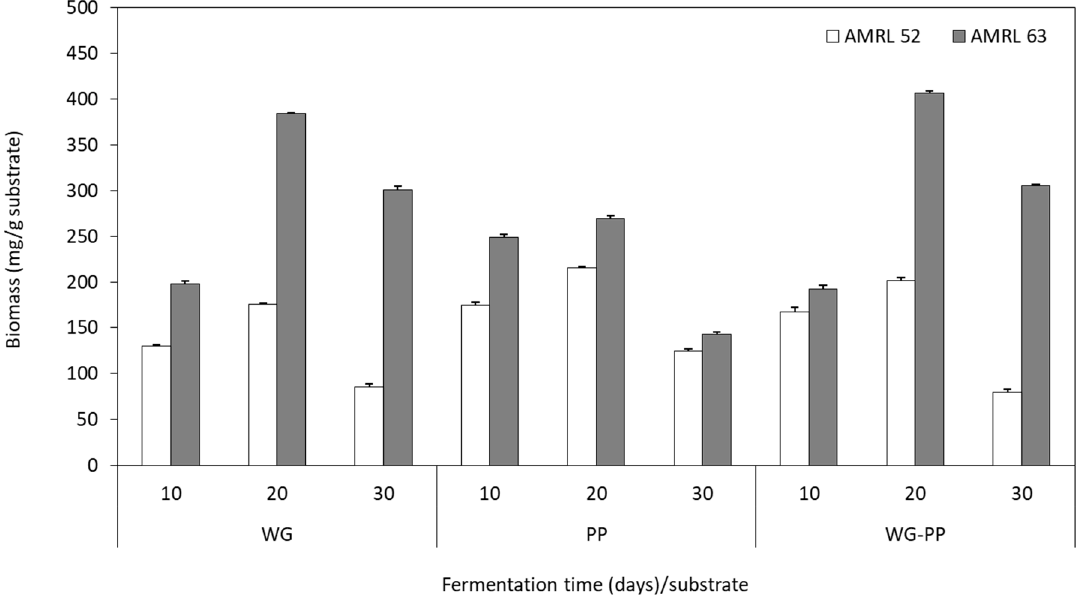
Figure 4. Estimated mycelium mass accumulation of yellow AMRL 52 and black AMRL 63 morel strains during solid-state fermentation on wheat grains (WG), potato peels (PP), and a mixture of them (WG–PP, 1:1).